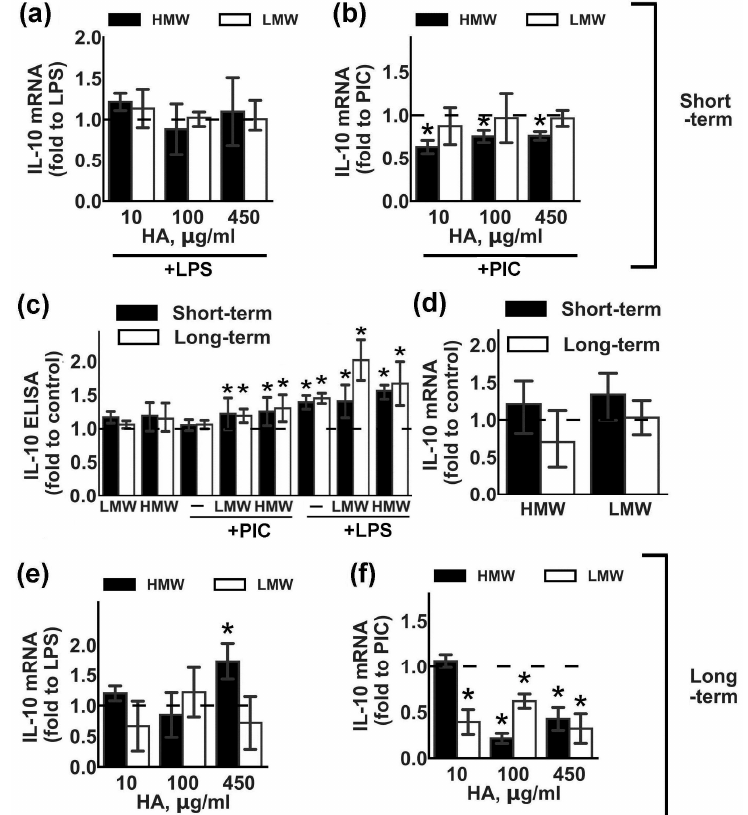
Figure 2. Effects of low molecular weight (LMW) and high molecular weight (HMW) hyaluronic acid (HA) on the expression of IL-10 upon stimulation with TLR3 and TLR4 agonists. Astrocytes were pretreated for 0.5 or 48 h with HMW (10,100 or 450 µg/mL) and LMW (10,100 or 450 µg/mL) HA alone or in combination with LPS (100 ng/mL) or PIC (10 µg/mL) for 4 h. Relative IL-10 mRNA levels were determined by real-time PCR, the data were normalized to β -actin mRNA levels. Results in ( a , b , e , f ) are presented as fold-changes of IL-10 relative to LPS or PIC-stimulated cells. Results in (d) are presented as fold-changes of IL-10 relative to the control cells. ( c ) IL-10 concentrations were measured by ELISA in supernatants from samples with long- (white bars) and short (black bars) -term HMW (450 µg/mL) and LMW (450 µg/mL) HA pretreatment followed by LPS or PIC stimulation for 4 h. Results in ( c ) are presented as fold-changes of IL-10 relative to the control cells. Values represent mean ± SEM from three independent experiments performed in triplicate. * p < 0.05, compared with the stimulated cells ( a , b , e , f ), * p < 0.05, compared with the unstimulated cells in ( c , d ).